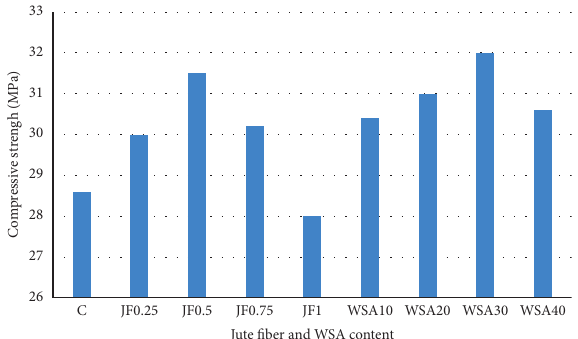
Figure 4: Compressive strength of mixture containing jute fiber and